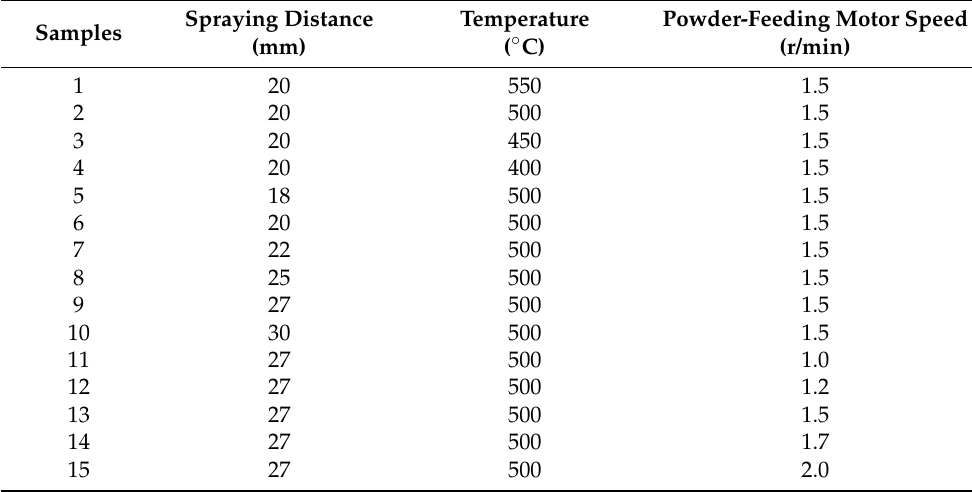
Figure 2. Trajectory of the spray gun. Table 3. Optimization experiment of temperature parameters of cold spraying.